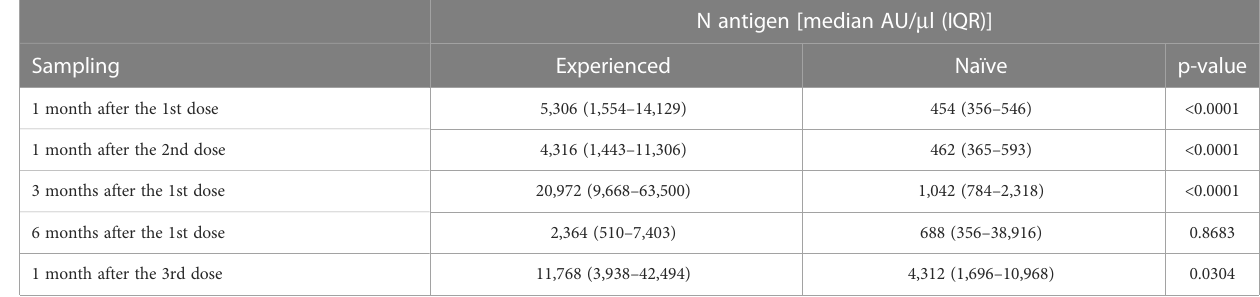
N antigen [median AU/ m l (IQR)]